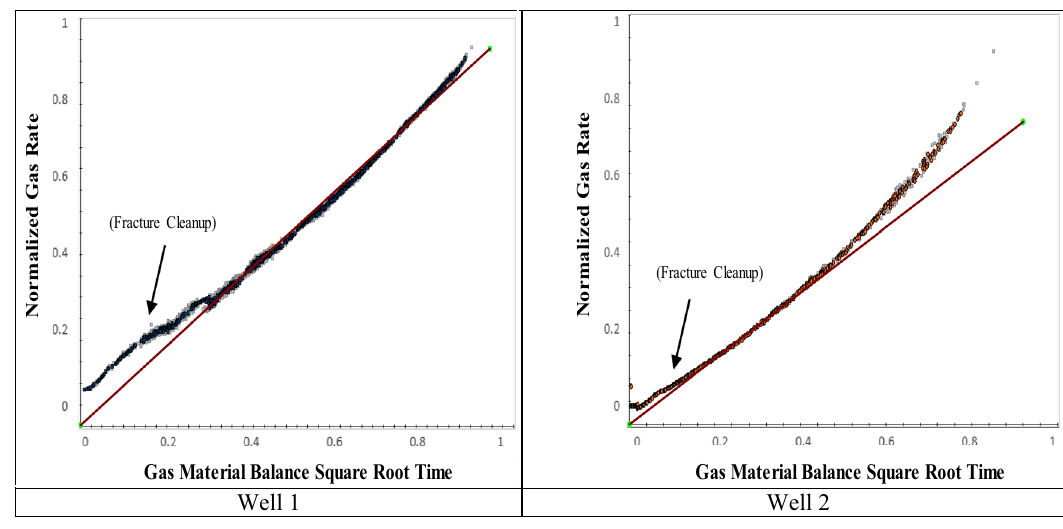
Fig. 4 Square root time plot versus normalized gas rate